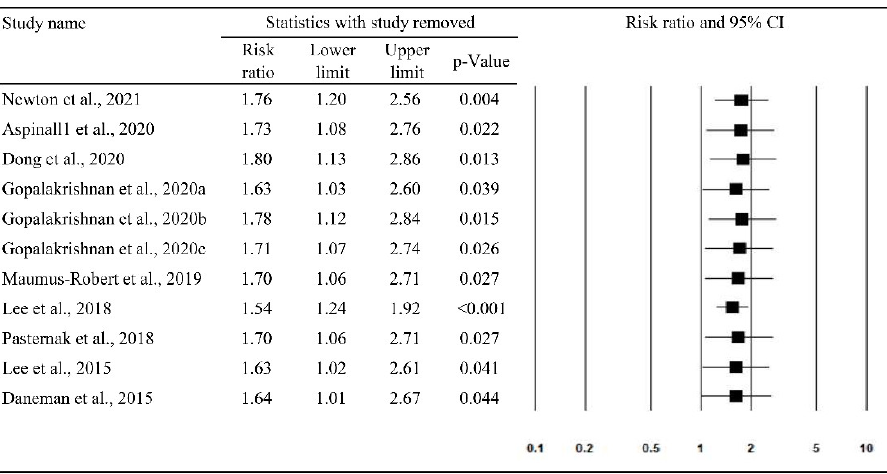
Figure 3. Forest plot of the risk of ( A ) aortic aneurysm/aortic dissection, ( B ) aortic aneurysm and ( C ) aortic dissection.